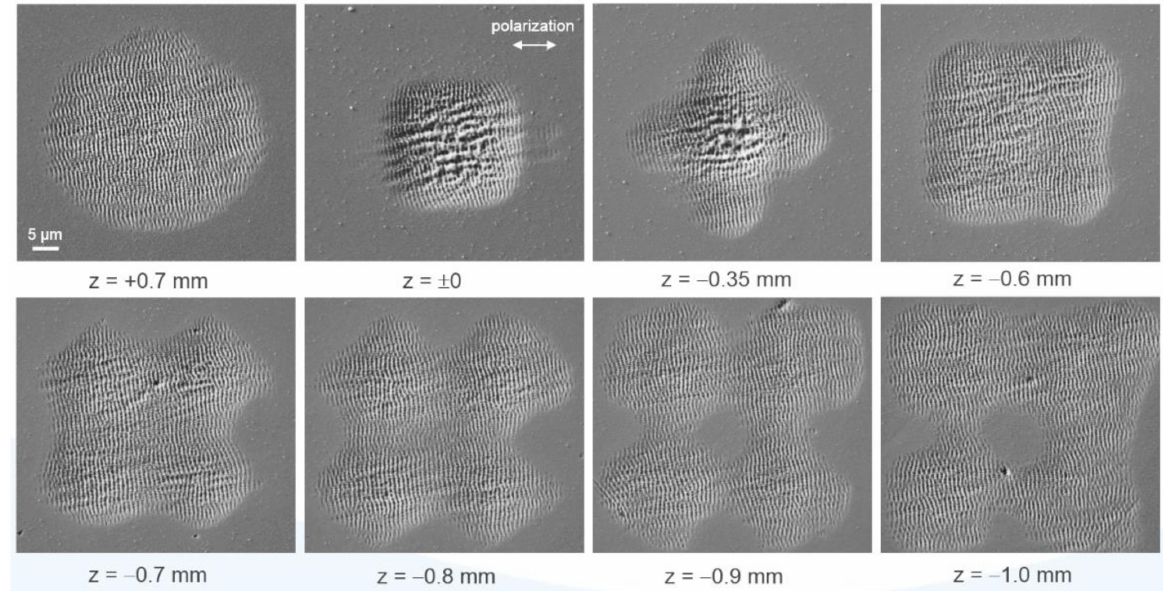
Figure 5. SEM micrographs of the stainless-steel surface after irradiation of 10 linearly polarized single fs-laser pulses at different z-positions of the sample surface within the focal intensity distribution. For comparability, the single-pulse energy was kept constant at E imp = 6.5 µ J.